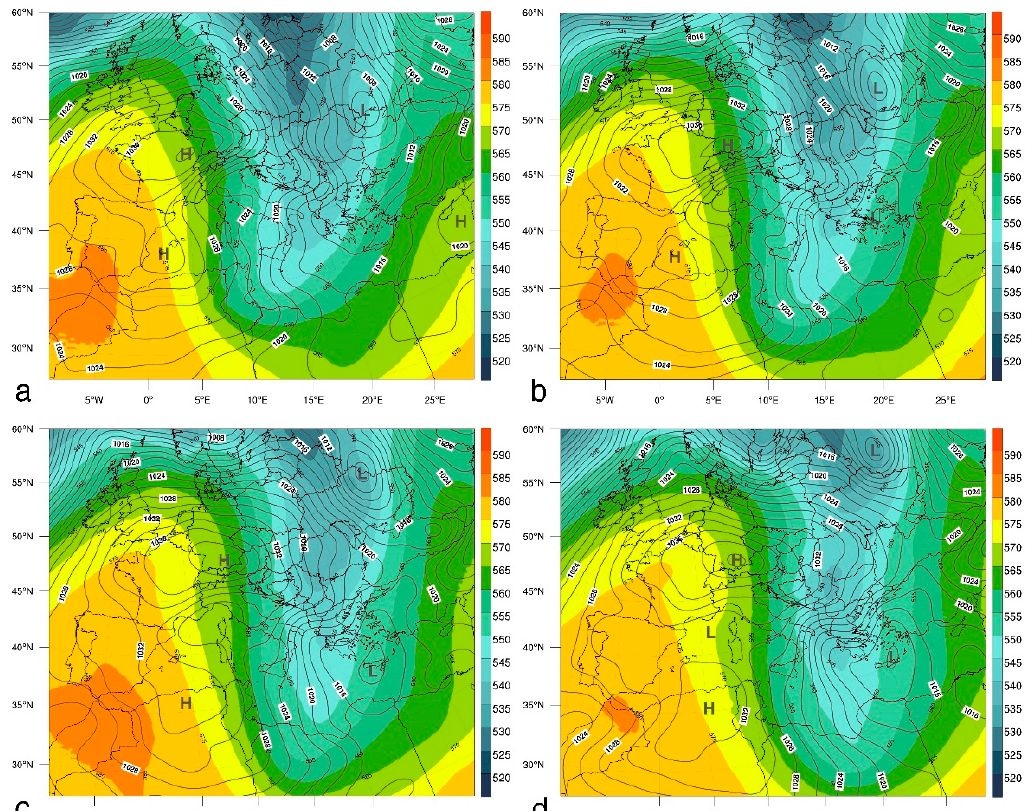
Figure A3. NCEP FNL analysis of 500-hPa geopotential height (shading at 50-gpdm intervals), sea-level pressure (thin black contours at 2-hPa intervals), valid at ( a ) 1200 UTC 12 February 2019, ( b ) at 1800 UTC 12 February 2019, ( c ) at 0000 UTC 13 February 2019, and ( d ) at 0600 UTC 13 February 2019.